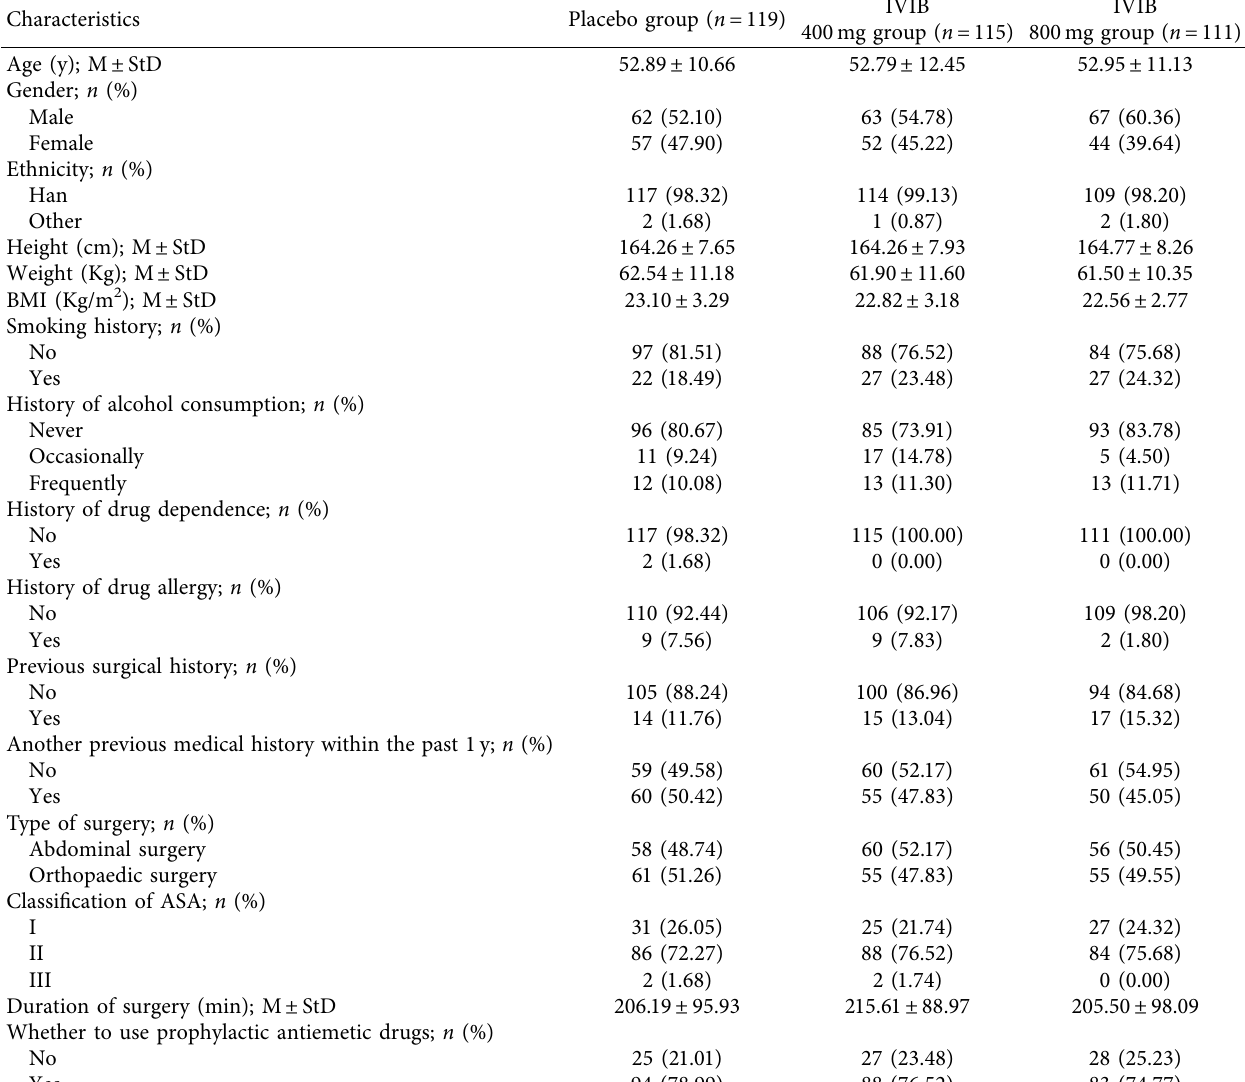
Table 1: Demographic profles and other information about